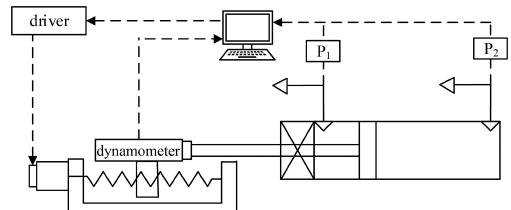
Figure 8. Friction test platform.